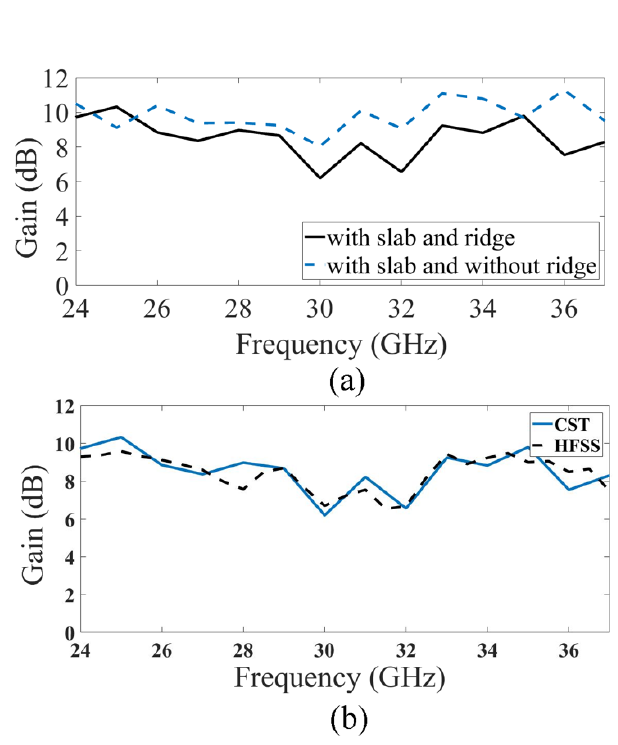
FIGURE 7. Simulated peak gain of the proposed antenna (a) CST simulation results of ridge being present or not, (b) comparison of CST and HFSS results of the proposed antenna with ridge present.